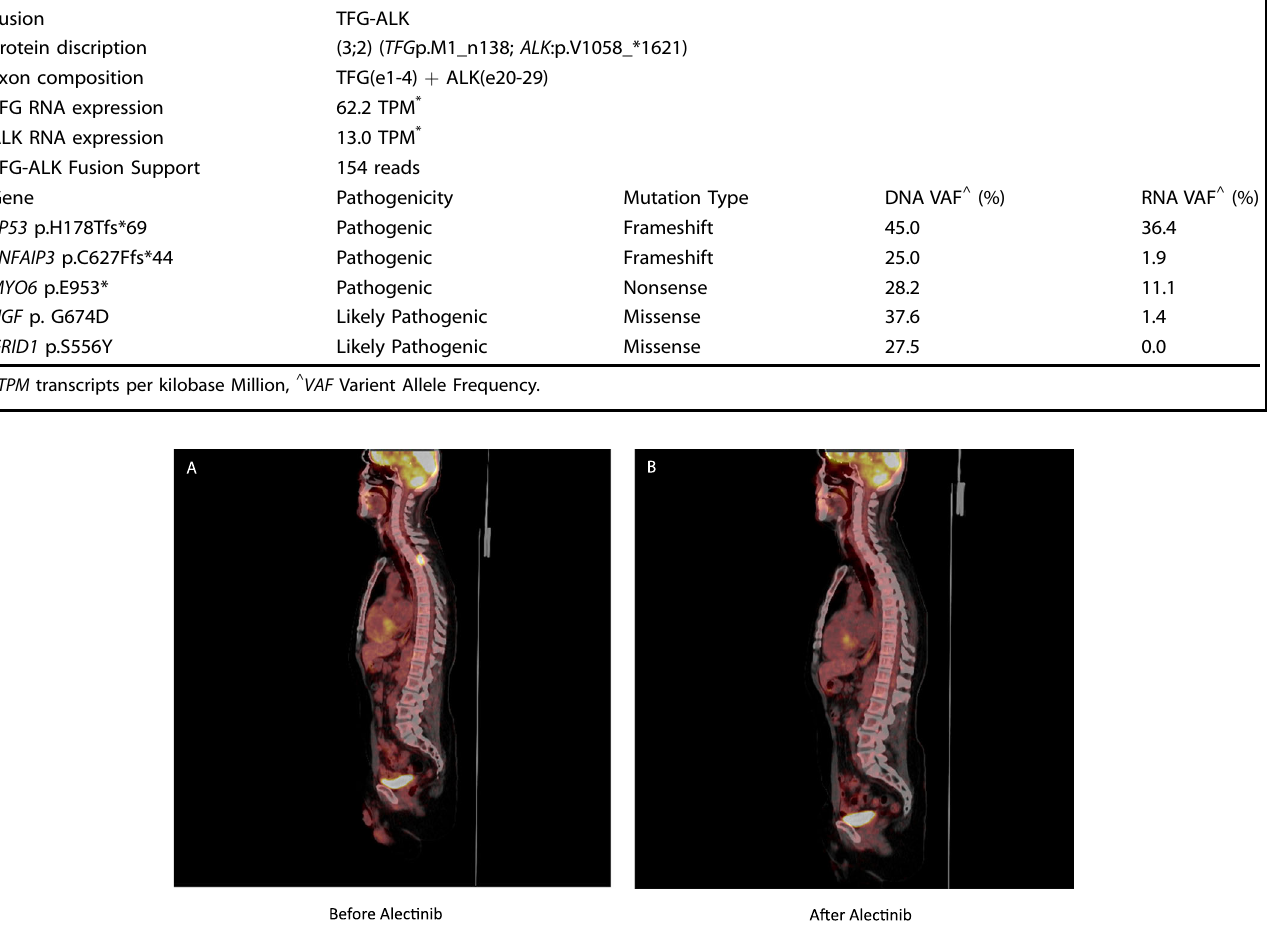
Fig. 1 PET Scan results. A Before initiation of Alectinib. Foci of increased uptake in a mediastinal lymph node (max SUV 6.3), retrocaval lymph node (max SUV 10.6), right T3/T4 intervertebral foramen (max SUV 14) on PET-CT. B Complete response after 2 months of alectinib. Complete resolution of prior noted upper thoracic spine lesion and upper abdominal pericaval